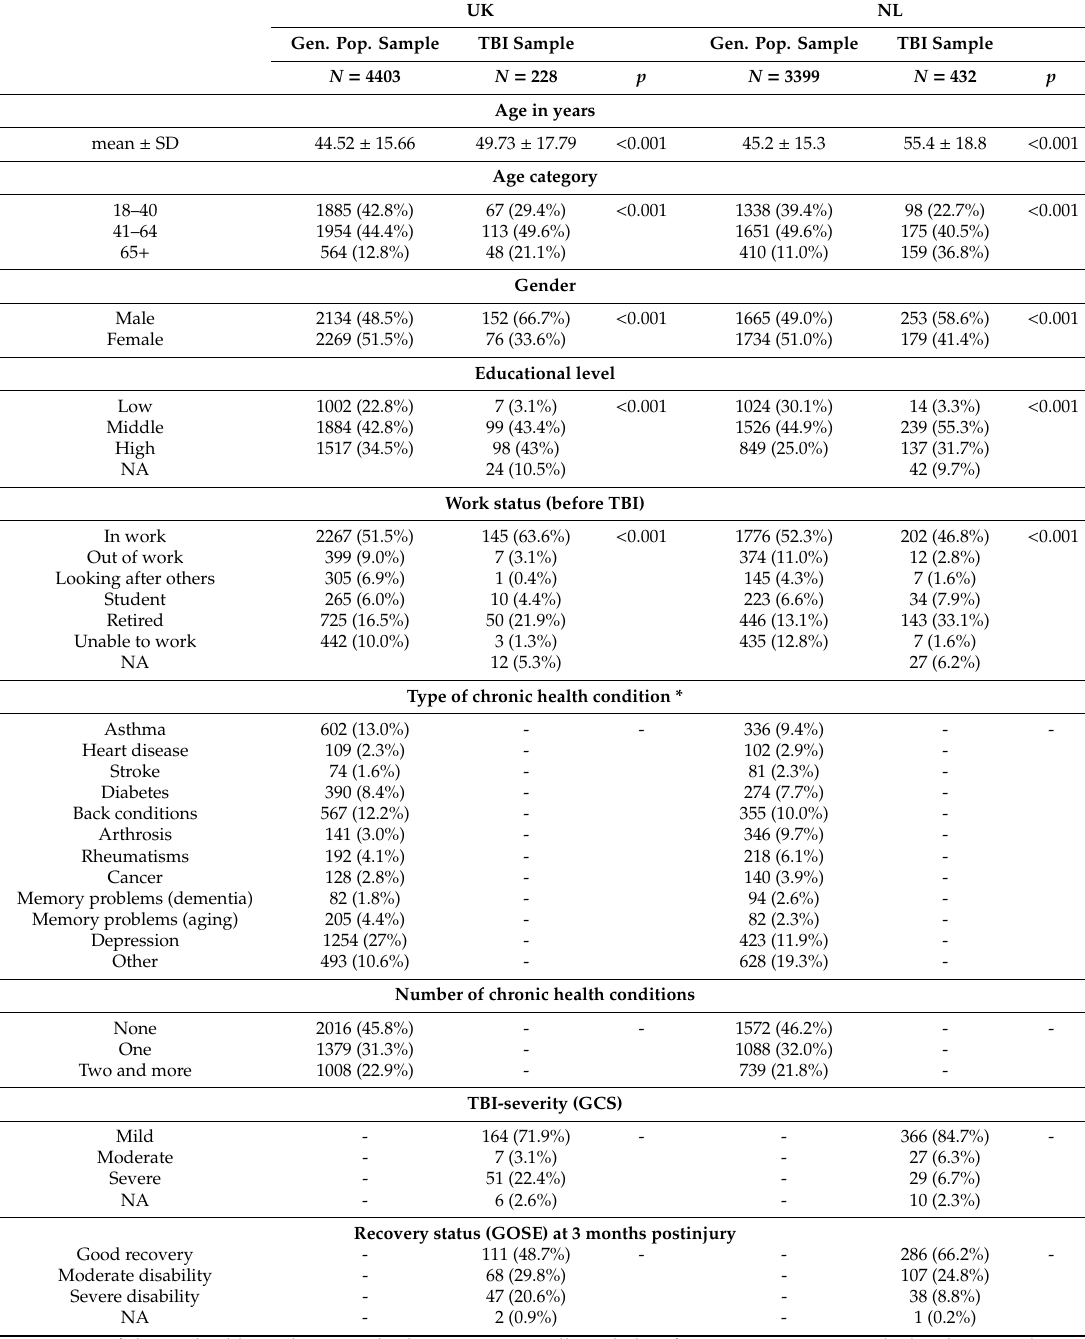
Table 1. Sociodemographic and health-related